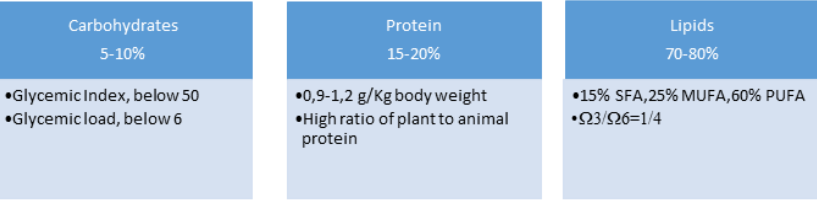
Figure 2. Qualitative and quantitative daily distribution of macronutrients into the future protocol proposed to be applied to patients with MS.